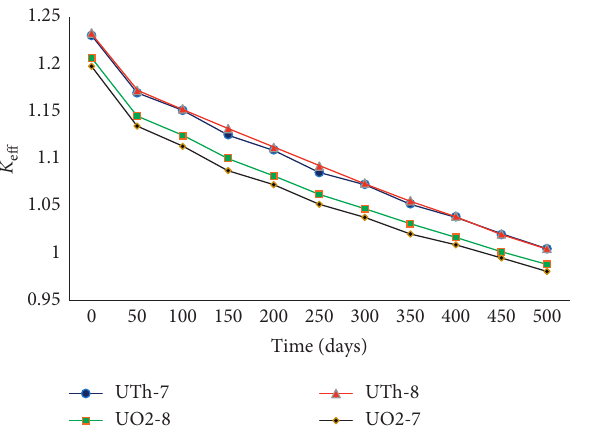
Figure 4: k eff variation with time.